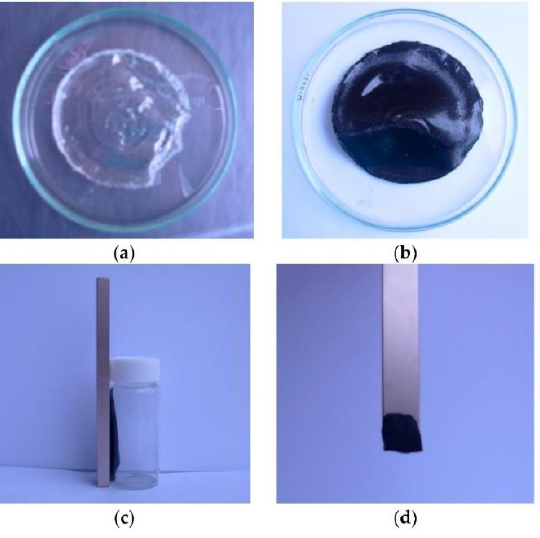
Figure 11. Images of the synthesized material ( a ) PVA gel; ( b ) PVA/Ni magnetic gel; ( c ) Ni-nanoparticles (NPs) in the magnetic field; ( d ) PVA/Ni magnetic gel in the magnetic field [133].